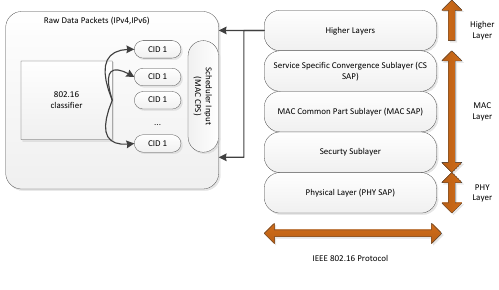
Figure 1. IEEE 802.16 Layer Protocols